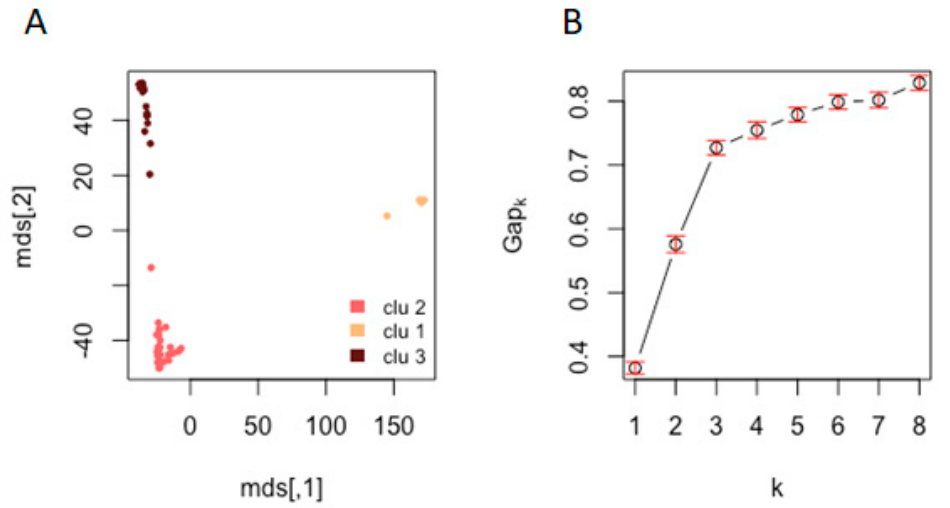
Figure 3. ( A ) Multidimensional scaling (MDS) plot of SNP profiles. ( B ) Gap curve where x-axis is the number of clusters and y-axis is the gap statistic. The MDS plot of 71 isolates (and Af293) and the gap curve show that samples could be clustered into three populations.